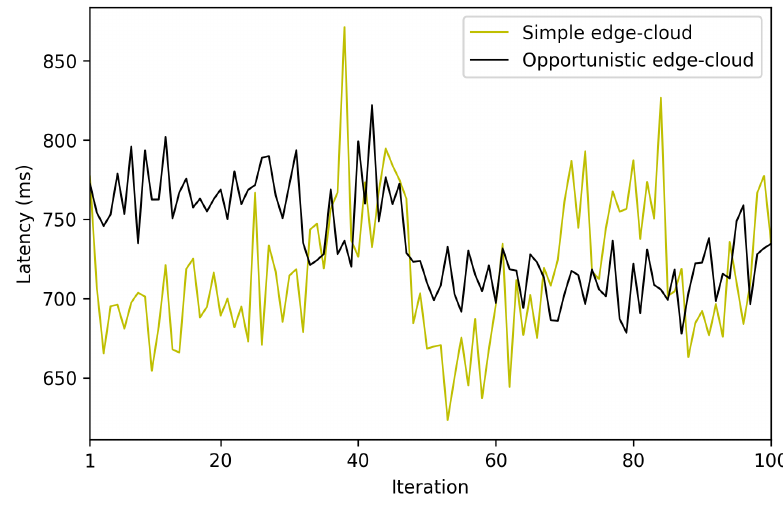
Figure 30. End-to-end latency comparison. Table 5. Hardware cost comparison of the proposed solution with other relevant state-of-the-art opportunistic